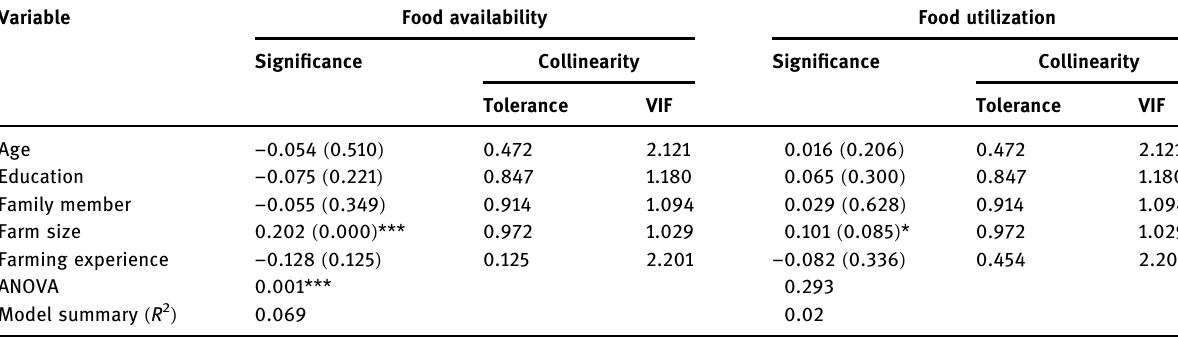
Table 9: Factors a ff ecting food availability ( multiple linear regression, sig. )